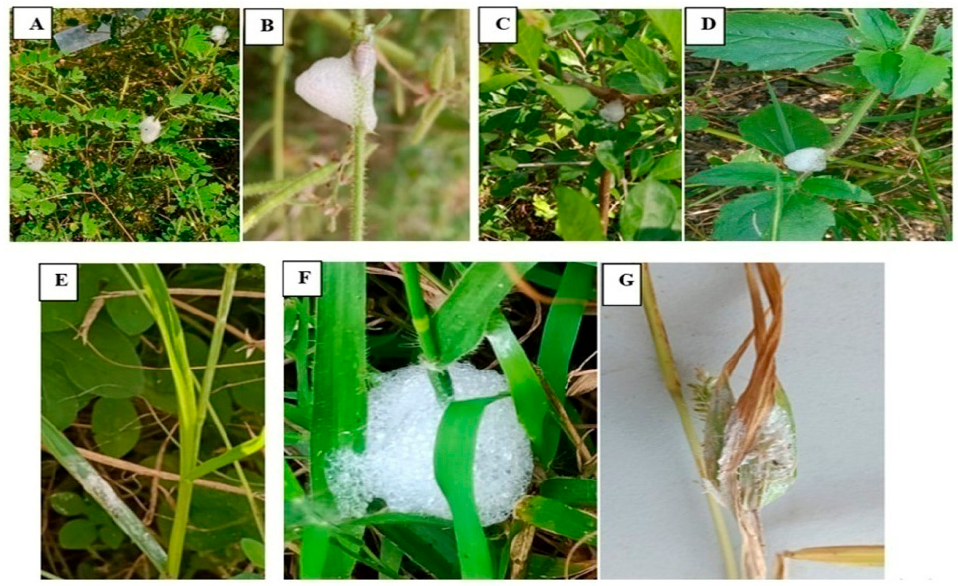
Figure 1. Production of foam by nymphal stages of P. costalis on T. purpurea ( A , B ), M. pudica ( C ), T. procumbens ( D ), and grasses ( E – G ). Discoloration of grass leaf blades ( E ) and joining of both leaf blades and inflorescence ( F